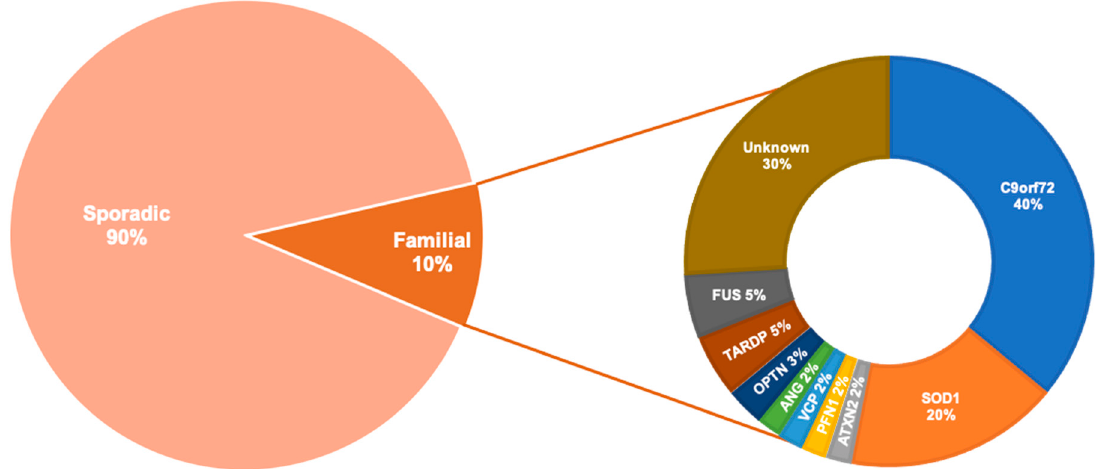
Figure 1. The prevalence of the most commonly known genetic causes of Amyotrophic Lateral Sclerosis (ALS). Other genes that are more rarely associated with ALS are not included in the diagram above are: sequestosome 1 (SQSTM1), dynactin subunit 1 (DCTN1), VAMP associated protein B and C (VAPB), D-amino acid oxidase (DAO), TATA-box binding protein associated factor 15 (TAF15), ubiquilin 2 (UBQLN2), heterogenous nuclear ribonucleoprotein A1 (hnRNPA1), heterogenous nuclear ribonucleoproteins A2 / B1 (hnRNPA2B1), matrin 3 (MATR3), tubulin alpha 4a (TUBA4A), sec1 family domain containing 1 (SCFD1), myelin associated oligodendrocyte basic protein (MOBP), chromosome 21 open reading frame 2 (C21orf2), cyclin F (CCNF), NIMA related kinase 1 (NEK1), neurofilament heavy (NEFH), dnaJ heat shock protein family (DNAJ), EWS RNA binding protein 1 (EWSR1), senataxin (SETX), calcium- responsive transactivator (CREST), elongator acetyltransferase complex subunit 3 (ELP3), charged multivesicular body protein 2B (CHMP2B), alsin rho nucleotide exchange factor ALS2 (ALS2), sigma non-opioid intracellular receptor 1 (SIGMARI), FIG4 phosphoinositide 5-phosphatase (FIG4), spastic paraplegia 11 (SPG11), peripherin (PRPH), neuropathy target esterase (NTE), serum paraoxonase and arylesterase 1-3 (PON1-3), cholinergic receptor nicotinic alpha 3 (CHRNA3), cholinergic receptor nicotinic alpha 4 (CHRNA4), cholinergic receptor nicotinic beta 4 (CHRNB4), erb-b2 receptor tyrosine kinase 4 (ERBB4), coiled-coil-helix-coiled-coil-helix domain containing 10 (CHCHD10), amyotrophic lateral sclerosis 3 (ALS3), amyotrophic lateral sclerosis 7 (ALS7), amyotrophic lateral sclerosis 6-21 (ALS6-21), amyotrophic lateral sclerosis-frontotemporal dementia (ALS-FTD) [16] .